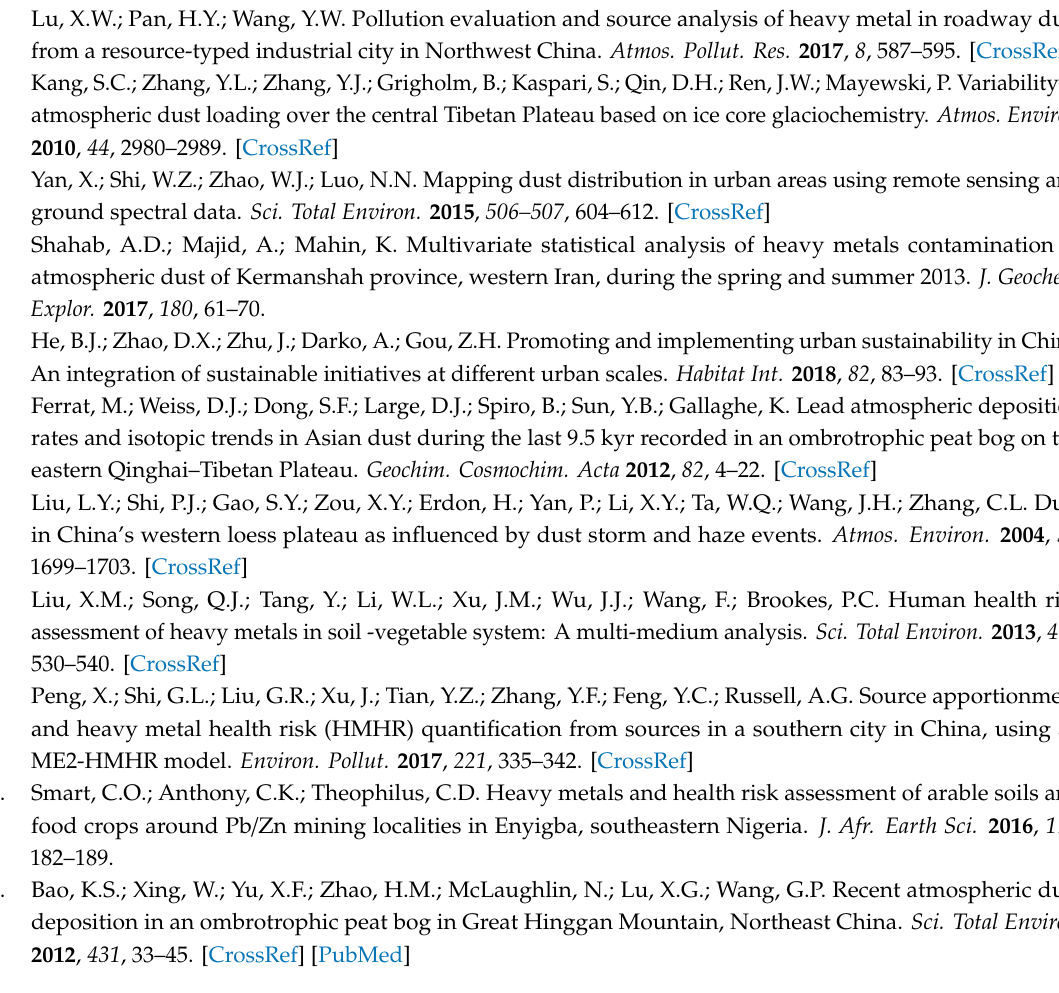
Table S1: Significance and value of health risk assessment parameters, Table S2: Analysis results for the Pb isotopes and pollution